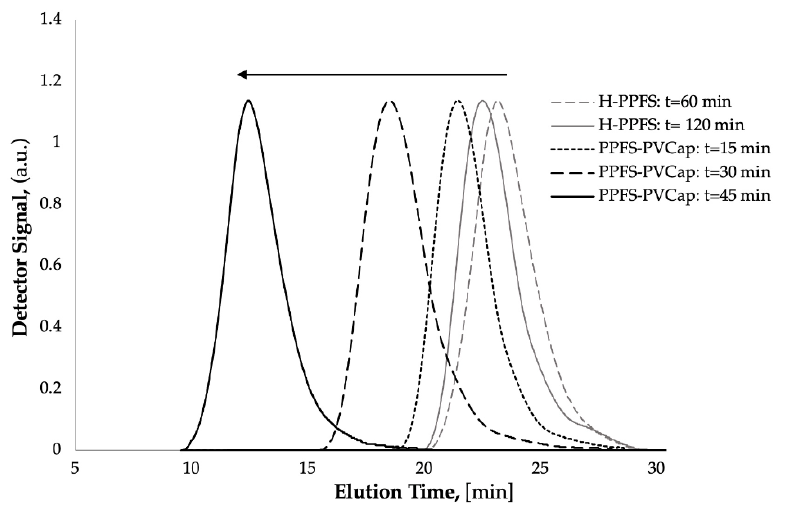
Figure 3. GPC chromatograms for synthesis of 1-PPFS macro-CTA followed by its subsequent chain extension with PVCap to form block copolymer PPFS-PVCap. H-PPFS indicates the homopolymer macro-CTA.